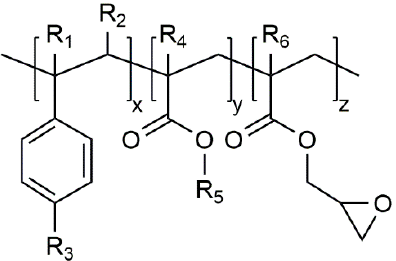
Figure 1. General structure of styrene–acrylic multi-functional chain extenders according [1].